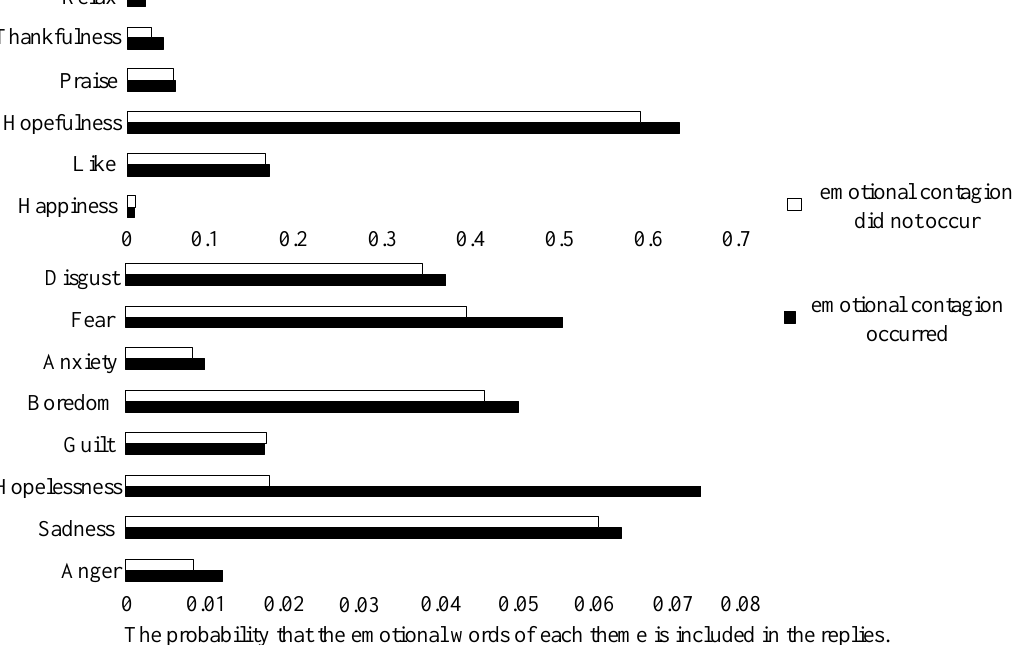
Figure 3. The themes of emotional interaction.